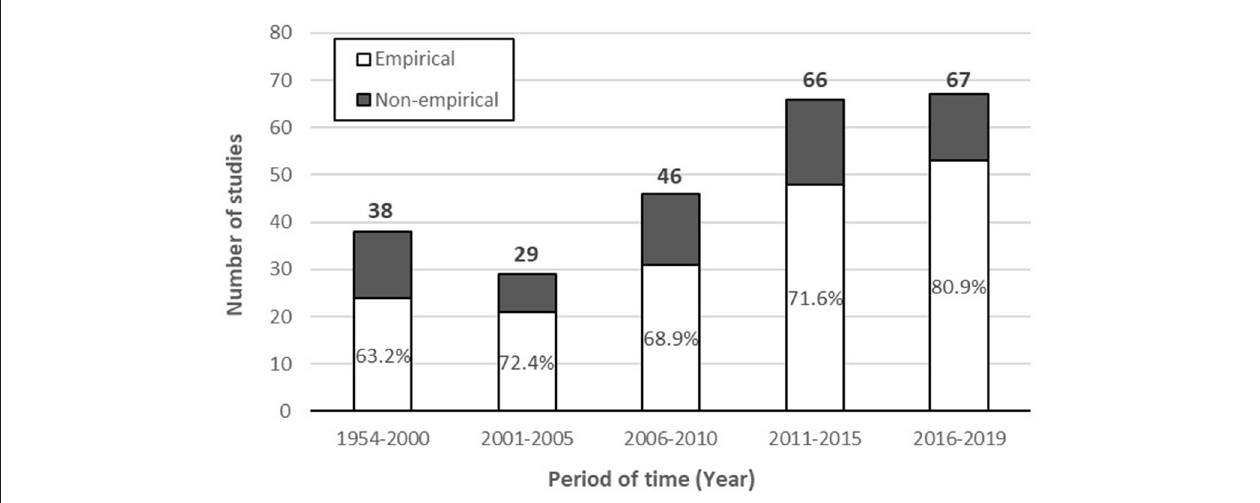
FIGURE 2 | Prevalence of empirical and non-empirical studies of well-being messaging for milk during each period (i.e., 1954–2000, 2001–2005, 2006–2010, 2011–2015, and 2016–2019). Numbers over each bar represent the total count of studies during each period. Empirical studies as a percent of total have been indicated inside the bars.